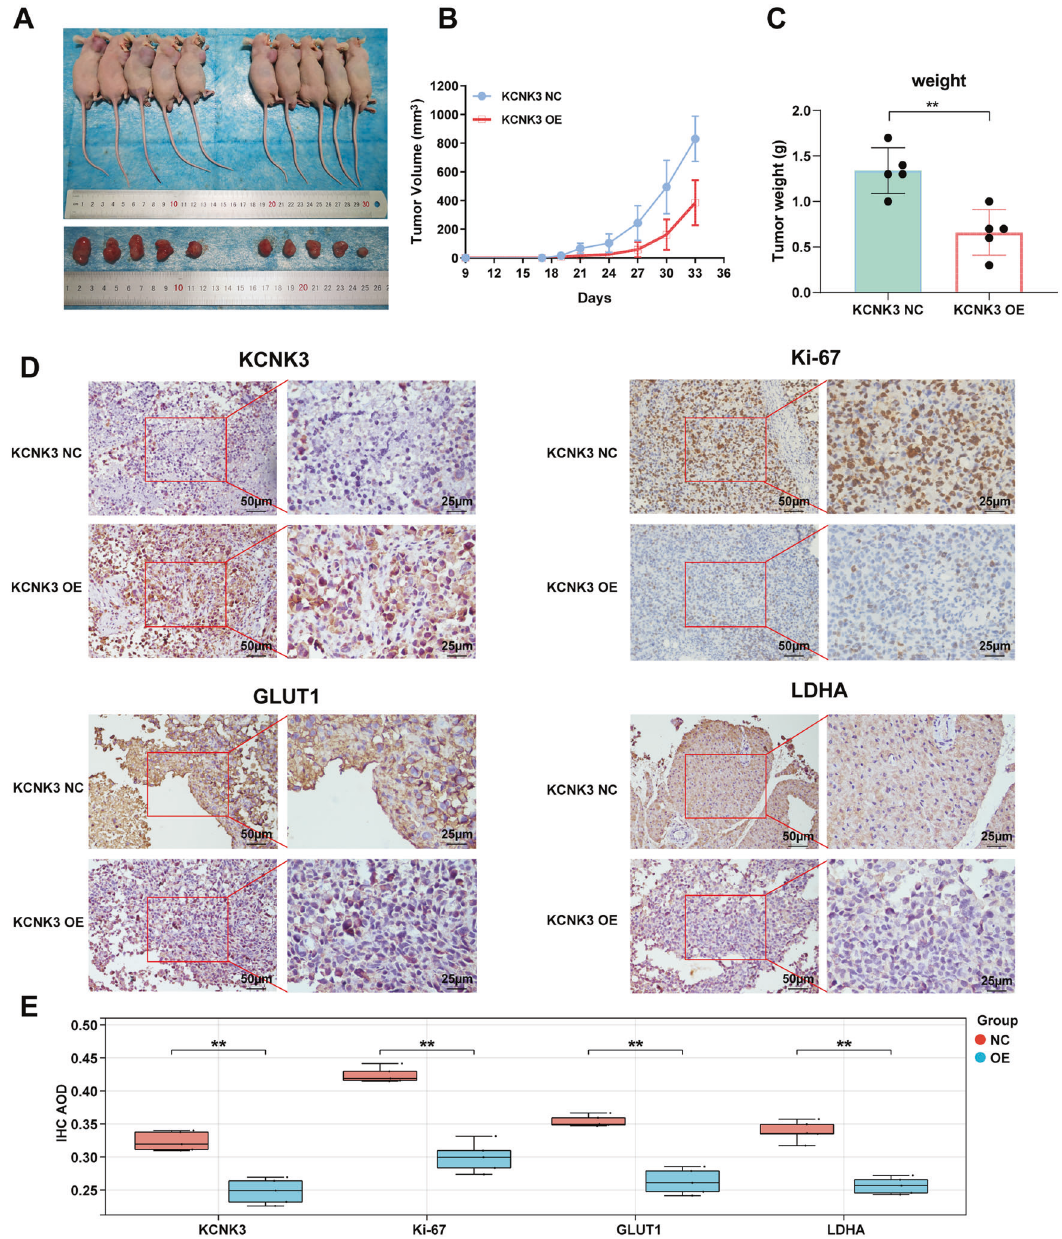
Fig. 4 Effect of KCNK3 on the tumor growth and glucose metabolism of LUAD cells in vivo. A Representative images of subcutaneous tumors and xenograft tumors was dissected from nude mice ( n = 5). B The growth curves for subcutaneous tumors in nude mice injecting with KCNK3-overexpressed H1299 cells. C Comparison of tumor weights from each group of nude mice. D The expression of KCNK3, proliferation-associated protein Ki67, and glucometabolic proteins GLUT1 and LDHA in tumor tissues of each group was detected by immunochemistry. Scale bar 50 or 25 µm. (Data are presented as the mean ± SD of three independent experiments. ** P < 0.01).